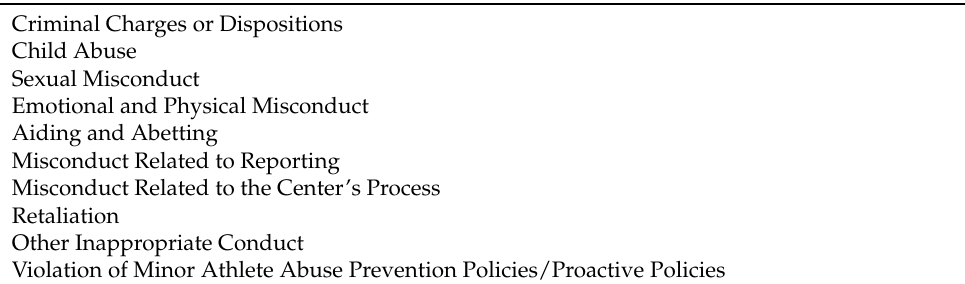
Table 1. SafeSport Prohibited